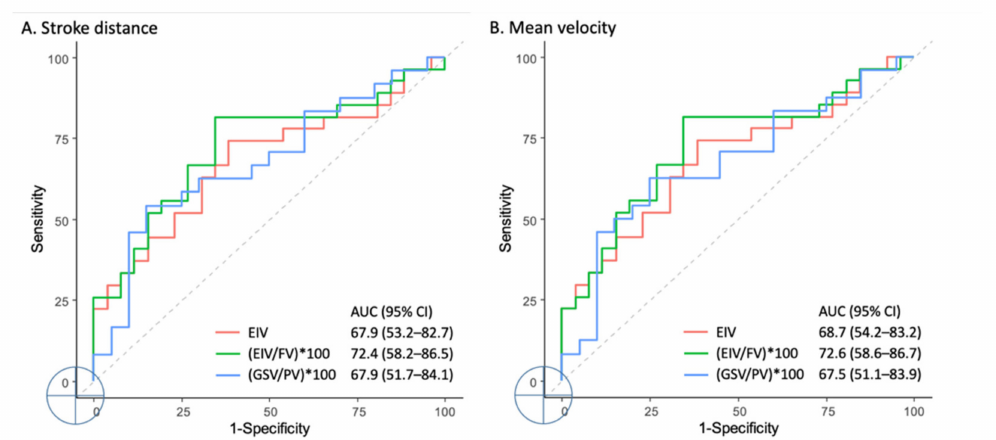
Figure 4. ROC curve of the stroke distance and mean velocity of the QFlow